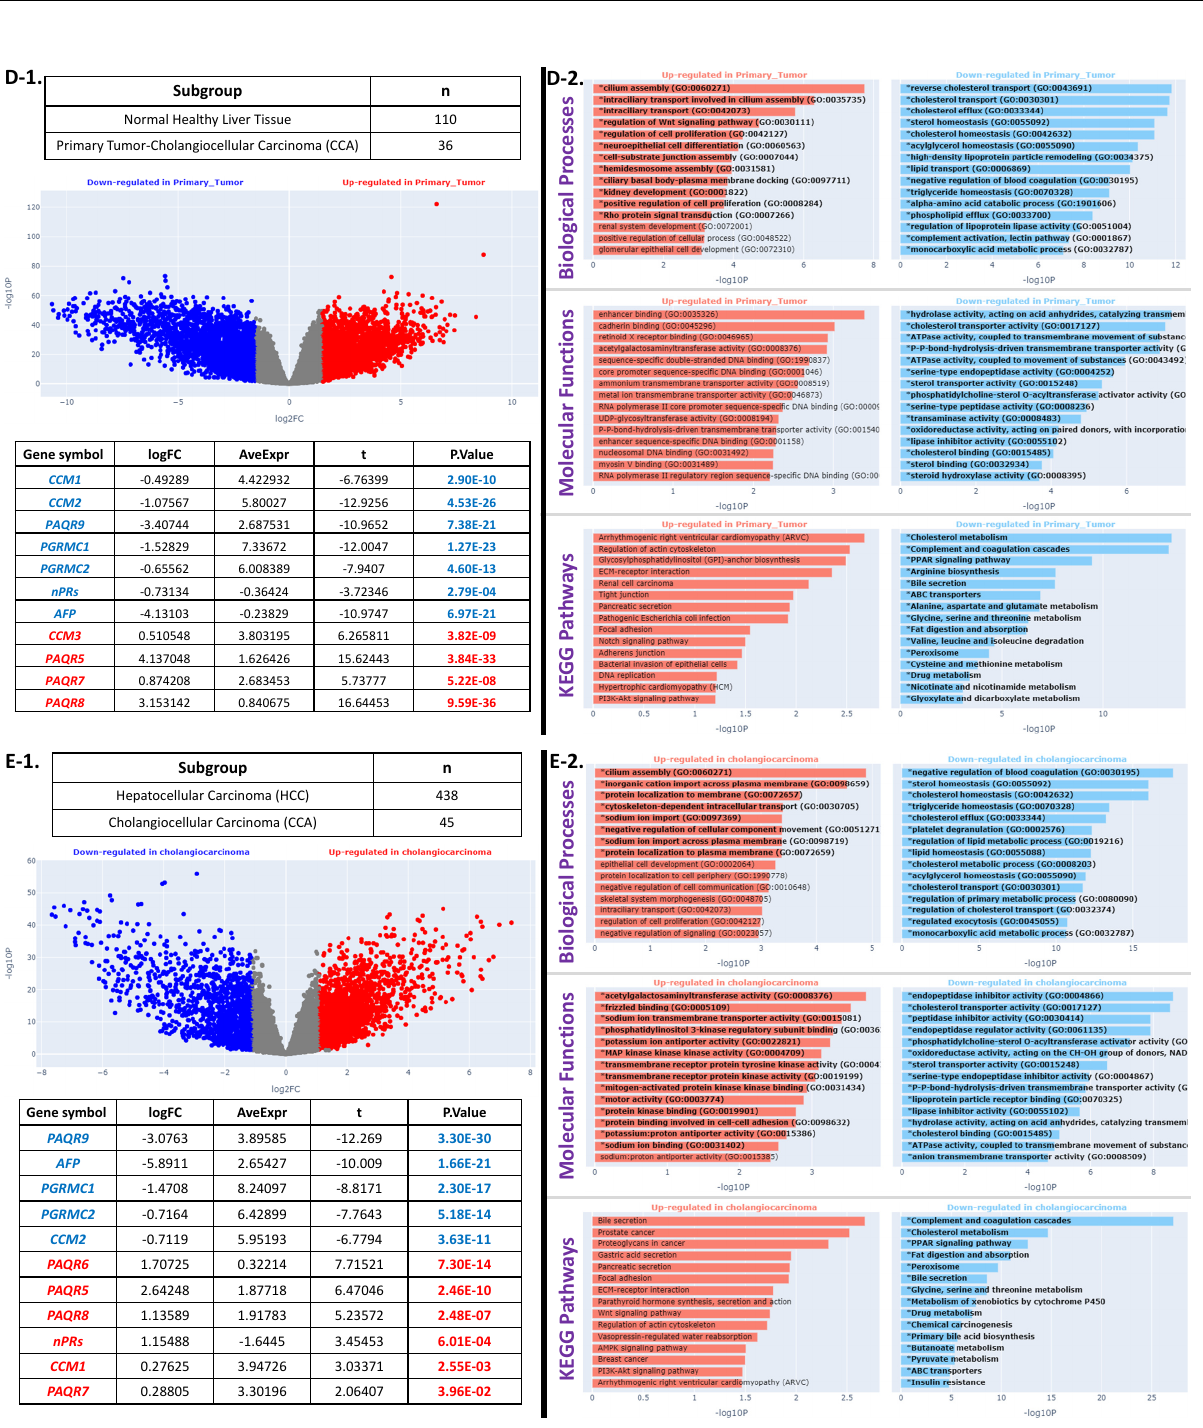
Figure 2. RNAseq expression profiling for key CmPn players utilizing multiple TCGA databases for hepatic cancers. We performed expression profiling for key CSC , mPR , and nPR players, along with established liver cancer biomarker AFP , using two types of ‘normal’ tissues utilizing the TCGA-TARGET-GTEX and TCGA-PANCAN databases: solid tissue “normal” which are taken from “normal” tissue, near the tumor site, and normal healthy tissue from individuals without cancer. ( A1–2 ) Differentially expressed genes (DEGs) of key CmPn players (along with AFP ) for HCCs (n = 531) and CCAs (n = 205), based on tissue type using the TCGA-TARGET-GTEX database. ( B1–2 ) Differential expression of key CmPn players (along with AFP ) for HCCs (n = 412) and CCAs (n = 45), based on tissue type using the TCGA-PANCAN database. ( C-1 ) Significant DEGs were profiled in a pair-wise fashion between normal healthy liver tissue (n = 110) and HCC primary